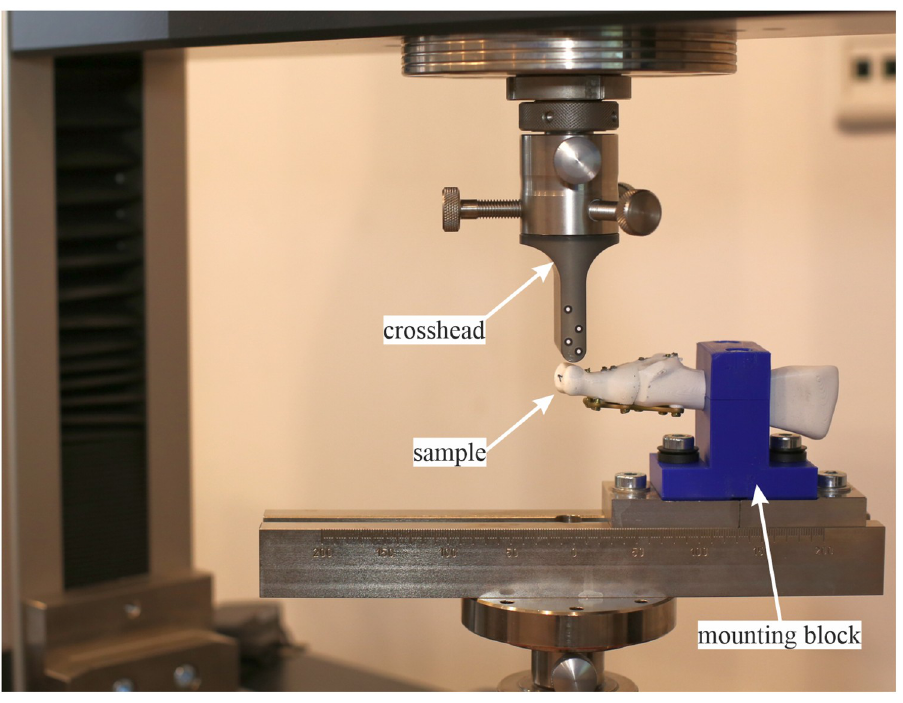
Fig 2. Experimental setup for the bending test.